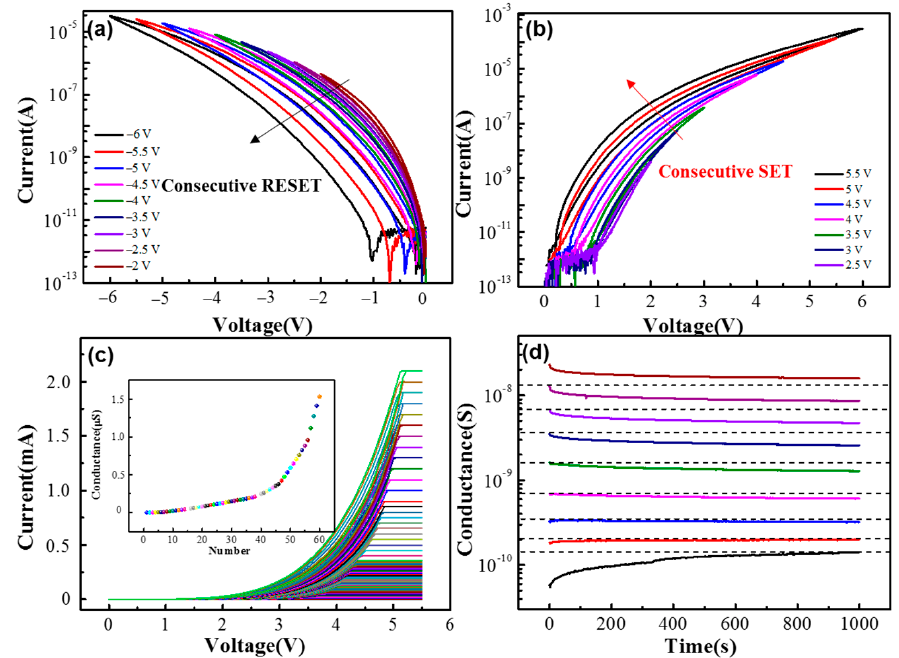
Figure 2. Bipolar analog-resistive switching characteristics of the Ta/TaO x /Al 2 O 3 /Pd device under the DC sweeping mode: ( a ) consecutive DC sweeping with different stop voltages from − 2 to − 6 V in the RESET process; ( b ) consecutive DC sweeping with different stop voltages from 2.5 to 5.5 V in the SET process; ( c ) consecutive DC sweeping with different compliance currents from 500 nA to 2.2 mA in the SET process (inset: 60 different conductance states obtained by modulating different compliance currents); and ( d ) retention characteristics of nine different resistance states of the Ta/TaO x /Al 2 O 3 /Pd device.